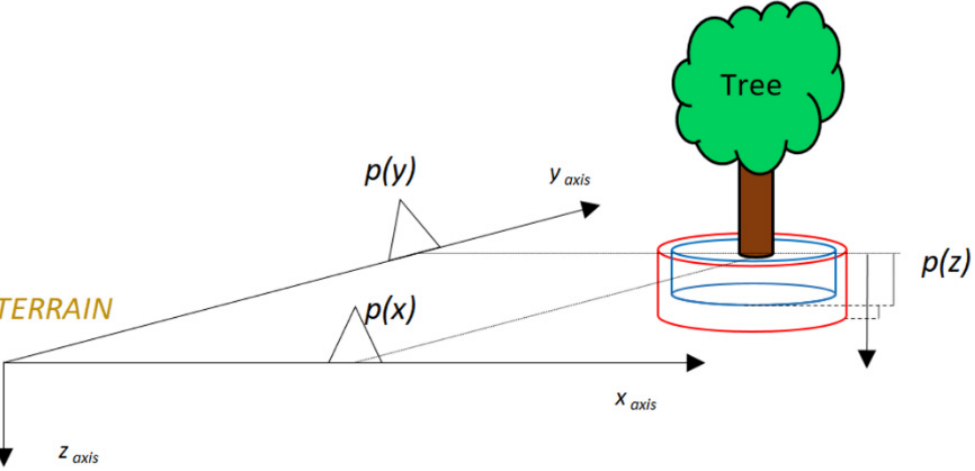
Figure 12. Integration of 3D original and convolved shapes in an RDF triple store. Based on a range of uncertainty models, the secondary geometric model is calibrated by combining the primary geometry dimensions convolved (Figure 12) with the probability density functions. A metric (Equation (1)) is associated to the secondary object to evaluate the probability that it bounds the primary object. Object uncertainty